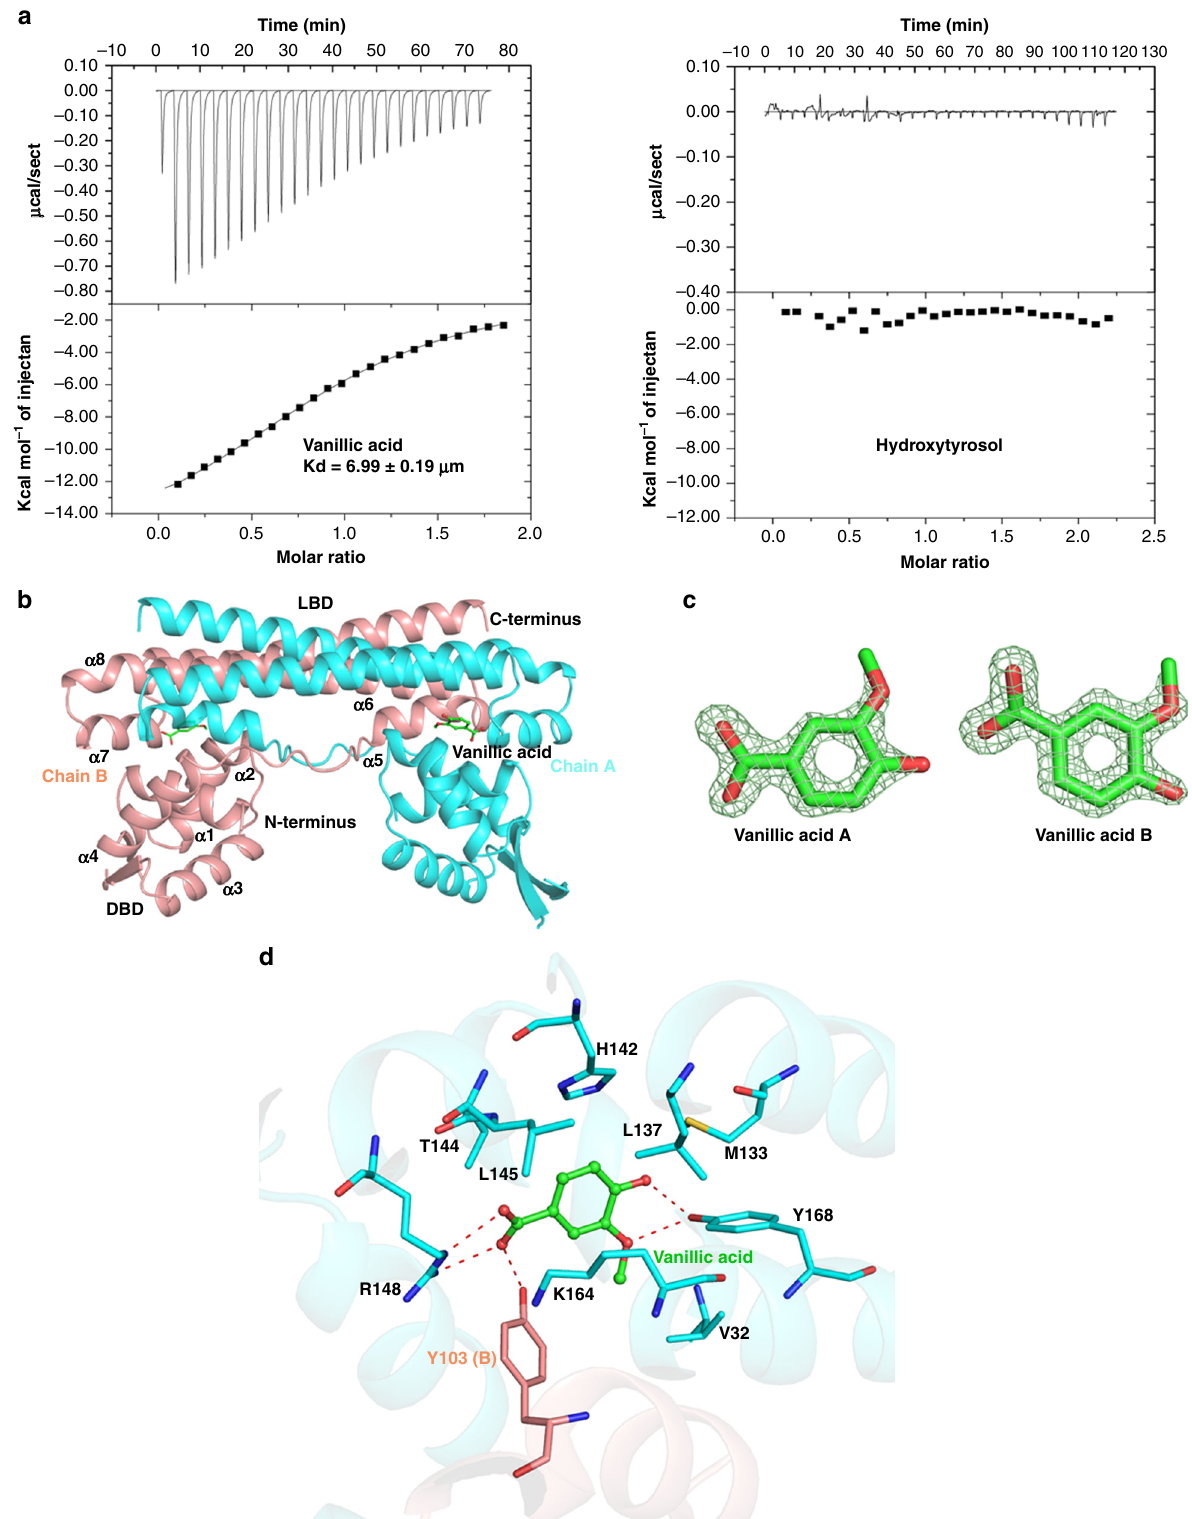
Fig. 2 Crystal structure elucidation of VanR complexed with vanillic acid. a ITC titrations of vanillic acid and hydroxytyrosol to wild-type VanR. The upper panels show the binding isotherms and the lower panels show the integrated heat for each injection fi tted to a single-site model. b Crystal structure of the VanR with bound vanillic acid. Subunits A and B are colored in cyan and light red respectively. c Fo-Fc electron density map of vanillic acid at the contour of 2.0 colored in light green; d The interaction of VanR with vanillic acid. Vanillic acid is shown in green stick and polar contacts are shown as red dash